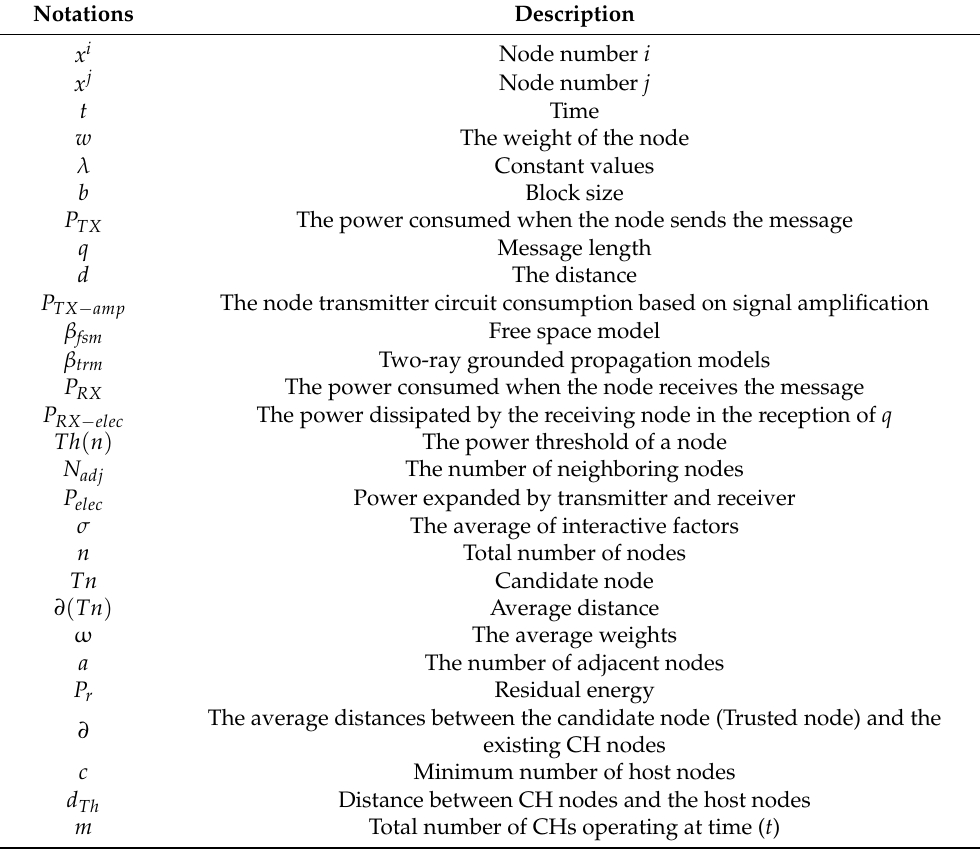
Table 2. Notations and their